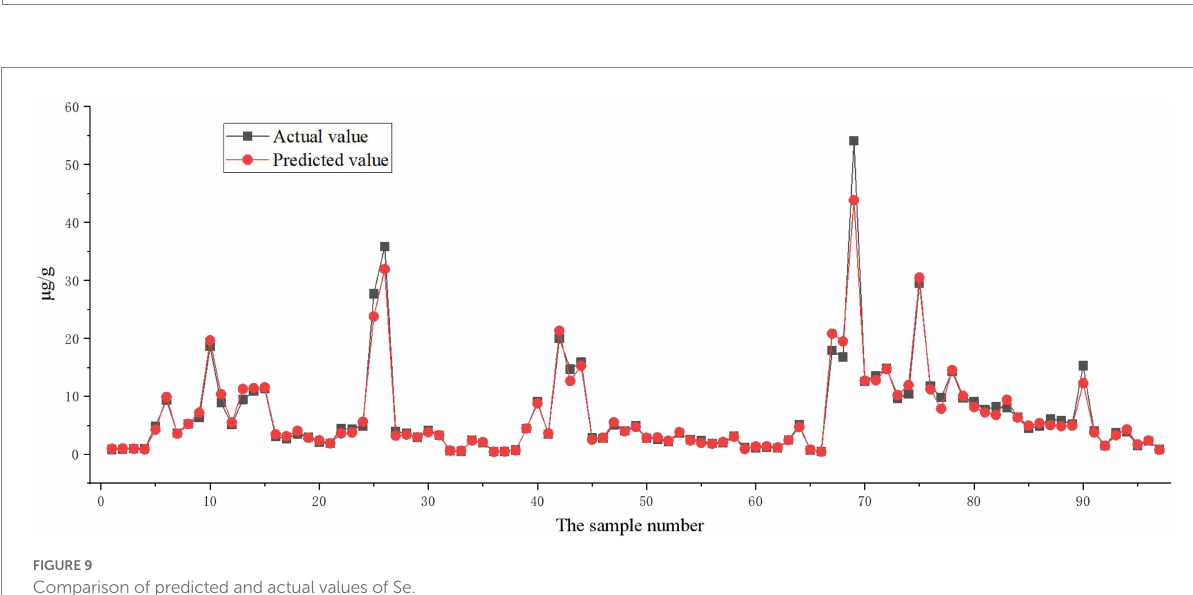
FIGURE 9 Comparison of predicted and actual values of Se.